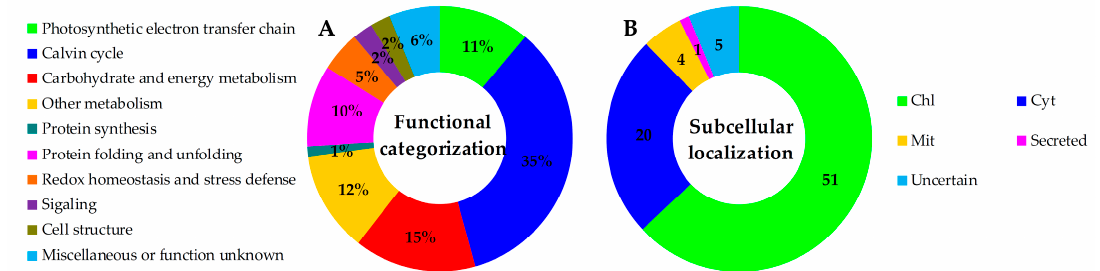
Figure 6. Functional categorization and subcellular localization of the identified 81 H 2 O 2 -responsive proteins from leaves of Populus simonii × Populus nigra . ( A ) The functional categories: The percentage of proteins in different functional categories is shown in the pie; ( B ) Subcellular localization groups of the identified proteins: The numbers of proteins with different locations are shown. Chl, chloroplast; Cyt, cytoplasm; Mit, mitochondrion.